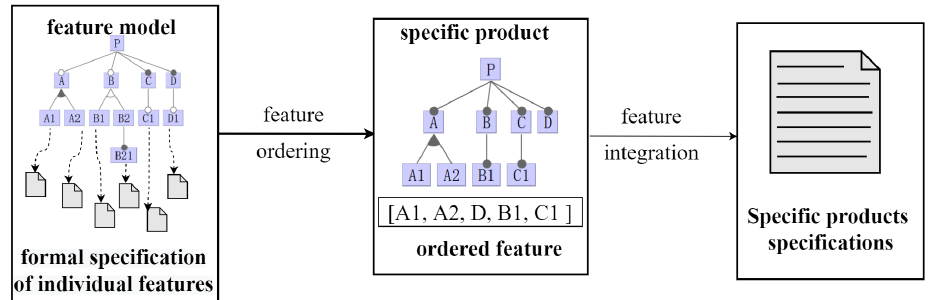
Figure 4. The outline of the product derivation